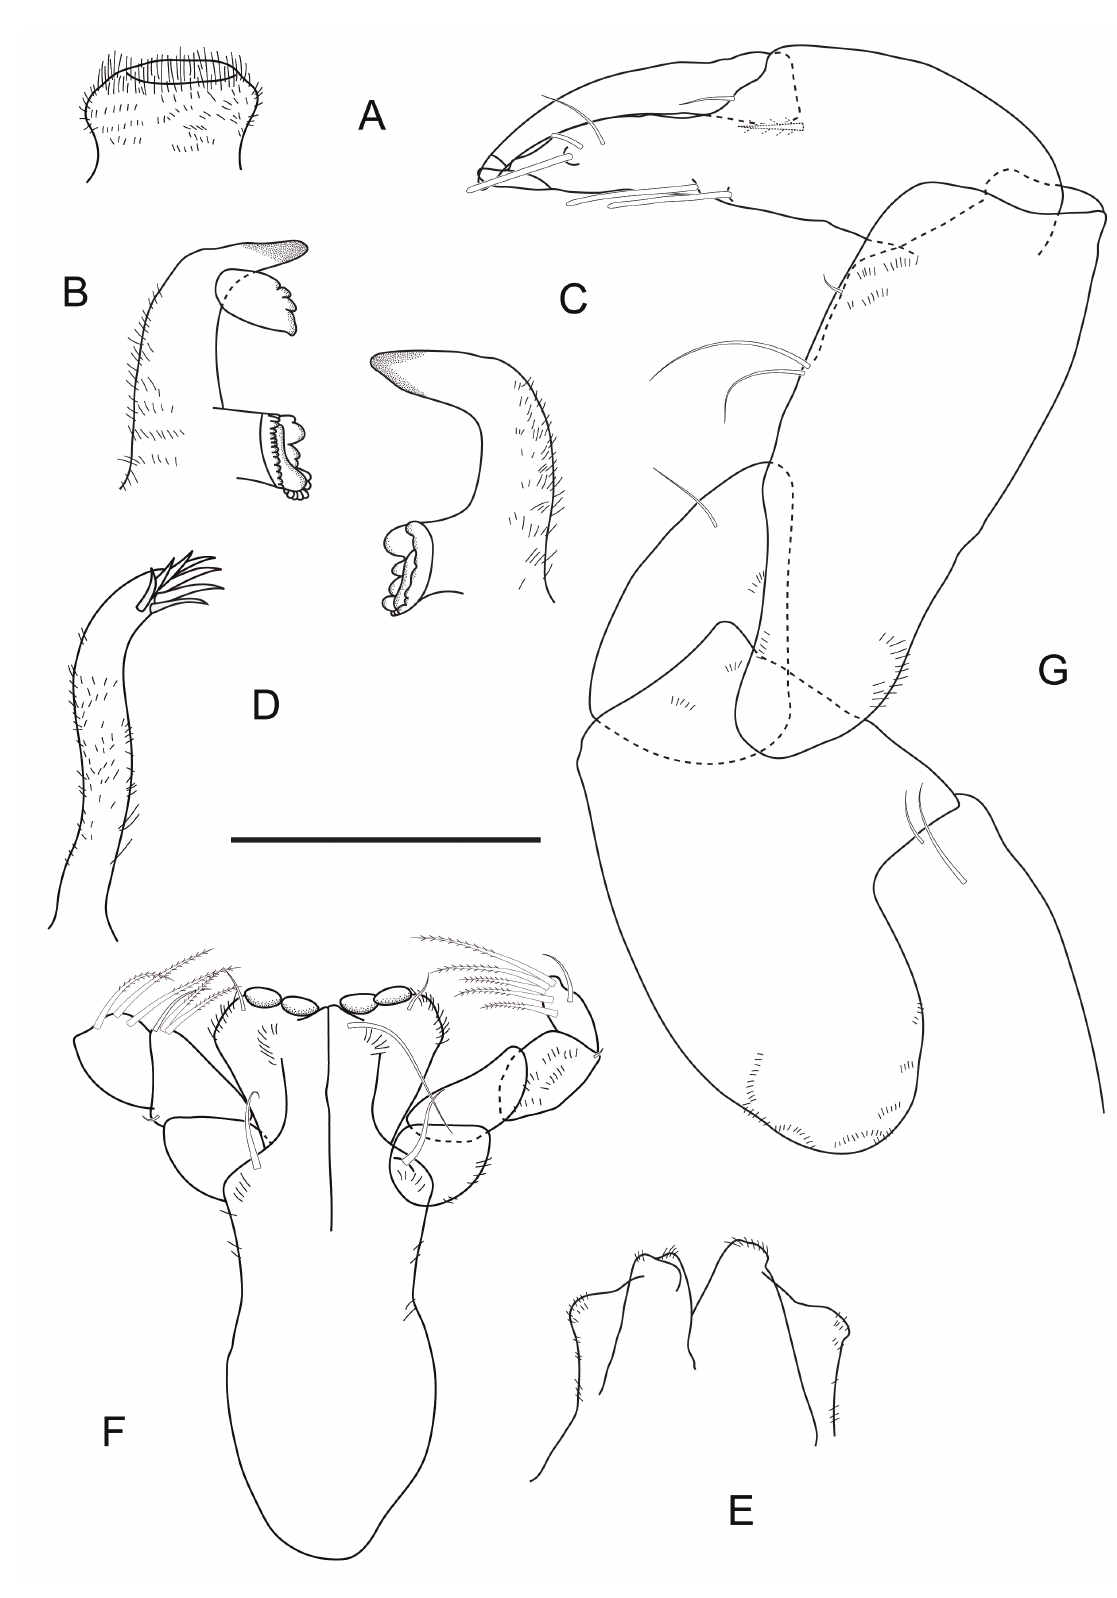
Fig. 3. Typhlotanais andradeorum sp. nov., paratype (MZUSP 32839), ♀, dissected. A . Labrum. B . Left mandible. C . Right mandible. D . Maxillule. E . Labium. F . Maxilliped. G . Cheliped. Scale bar = 0.1